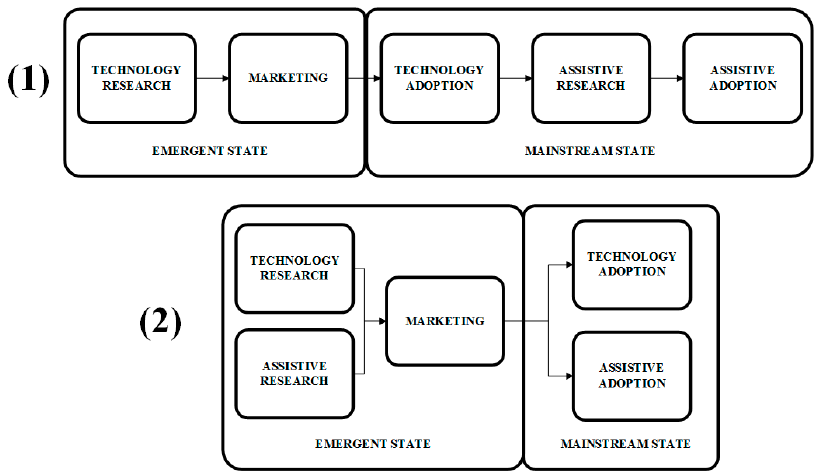
Figure 1. Assistive technology using widespread technologies: (1) traditional scenario and (2) proposed scenario in order to avoid differentiation with mainstream users